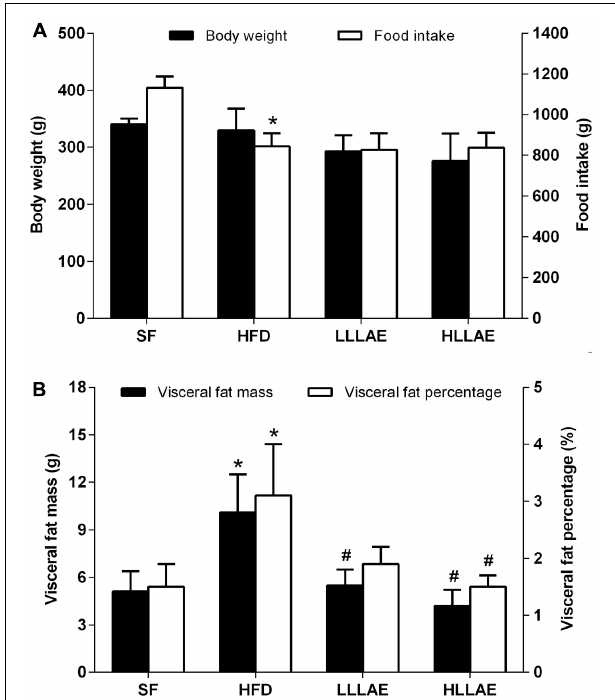
FIGURE 5 | Effects of LLAE on body weight, food intake (A) and visceral fat mass (B) in HFD-induced obese rats. HFD-induced obese rats were administrated with low dose LLAE [0.5 g crude drug/(kg.d), LLLAE] or high dose LLAE [3.0 g crude drug/(kg.d), HLLAE] for 6 weeks by gavages. Body weight and food intake were recorded, and visceral fat (epididymal and perirenal fat) mass was weighted as described in Section “Materials and Methods.” The visceral fat percentage was calculated by the percentage of body weight occupied by the visceral fat mass. The data represent the mean ± SD. ∗ P < 0.05 vs. SF group; # P < 0.05 vs. HFD group.